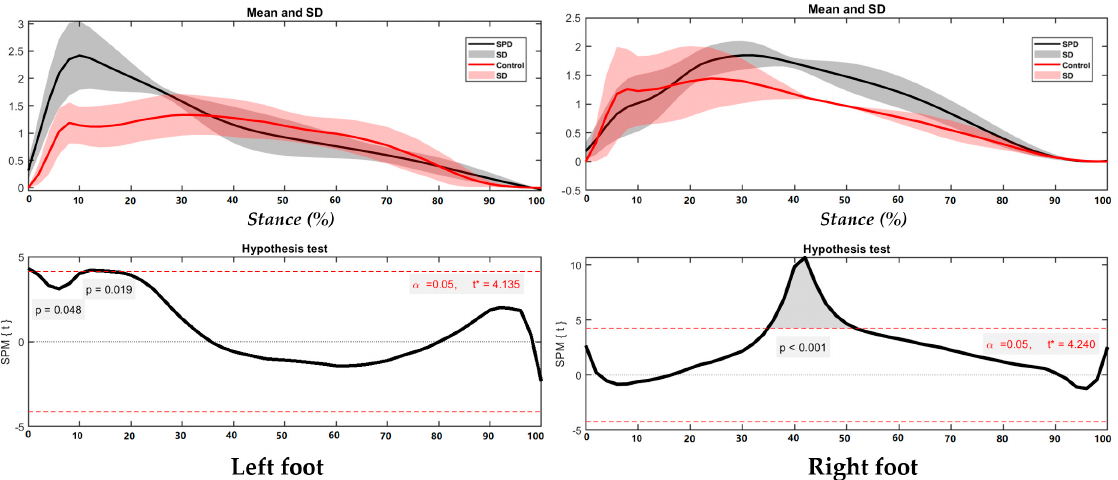
Figure 8. The vertical ground reaction force (GRF) in the left foot and right foot during turning in the SPD children and healthy controls (unit: Z avg ).